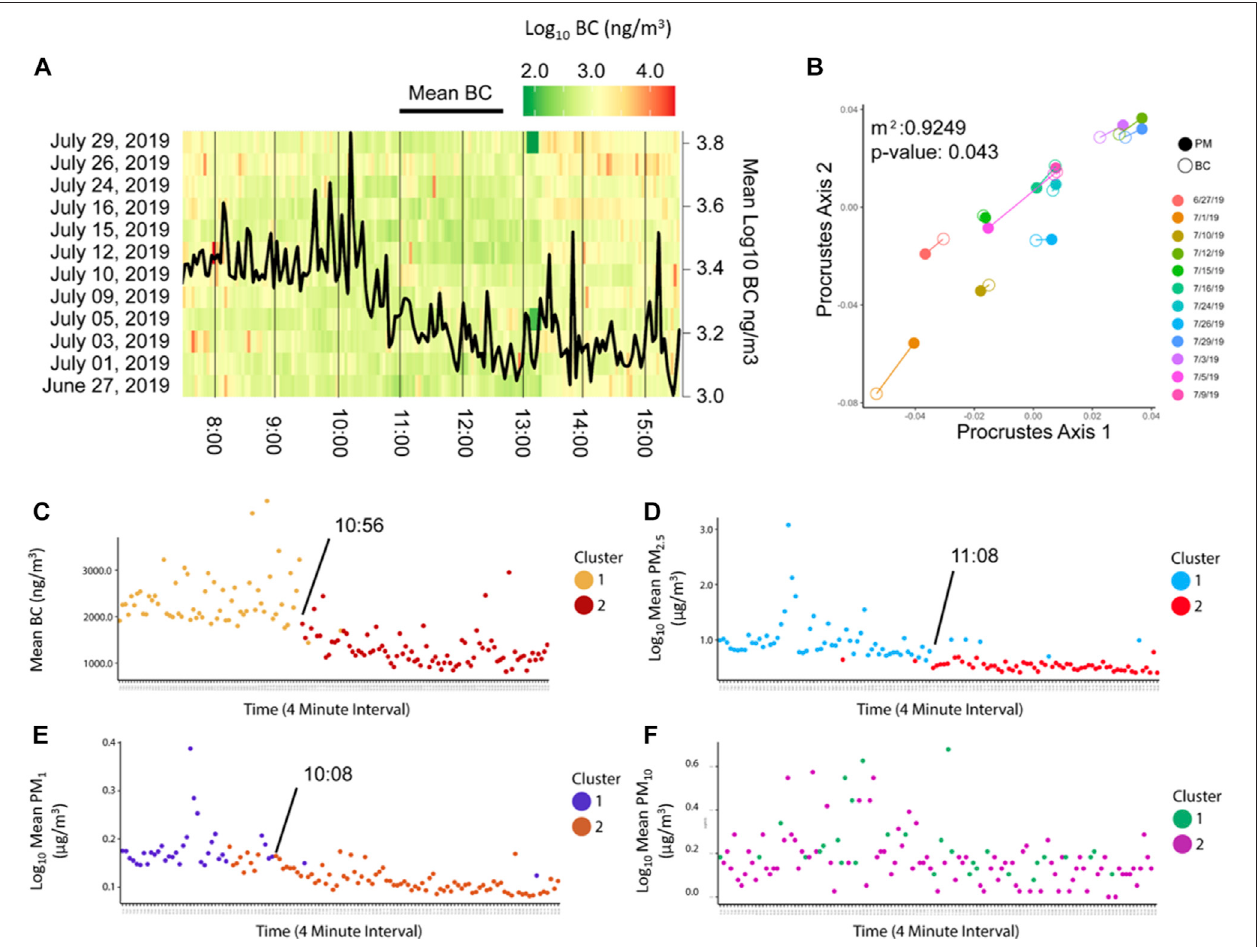
FIGURE5|(A) Heatmapshowingthelog 10 concentrationofBCacrosstime(x-axis)anddifferentdays(y-axis).Theblacklinere fl ectsthelog 10 meanconcentration ofBCaveragedacrossalldays. (B) ProcrustesrotationordinationofcorrelationbetweenBCandPM 2.5 onalldayswithcorrelationcoef fi cient(m 2 )anda p -value. (C) Plot of log 10 mean BC concentration over time, colored by cluster, determined by k-means clustering. (D) Plot of log 10 mean PM 2.5 concentration over time, colored by cluster, determined by k-means clustering. (E) Plot of log 10 mean PM 1 concentration over time, colored by cluster, determined by k-means clustering. (F) Plot of log 10 mean PM 10 concentration over time, colored by cluster, determined by k-means